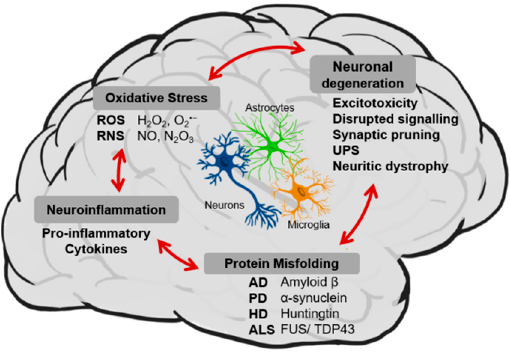
Figure 3. Main hallmarks of neurodegeneration and neurodegenerative diseases—protein misfolding, neuroinflammation, neuronal degeneration and oxidative stress—shared between the major cellular types present in the brain such as neurons, astrocytes and microglia. UPS: ubiquitin—proteosome system, ROS: reactive oxygen species, RNS: reactive nitrogen system, AD: Alzheimer’s disease, PD: Parkinson’s disease, HD: Huntington’s disease, ALS: amyotrophic lateral sclerosis.